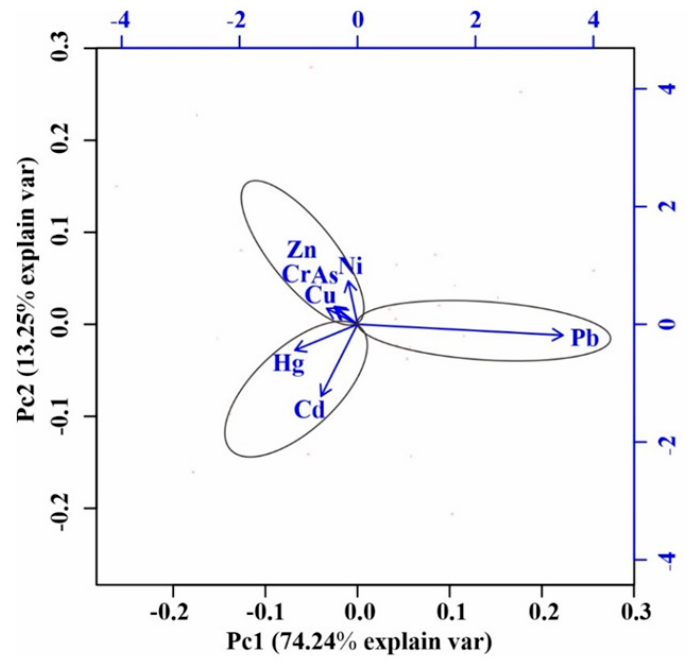
Figure 9. PC1 and PC2 biplot of the PCA in the surface sediments from Yueliang Lake.